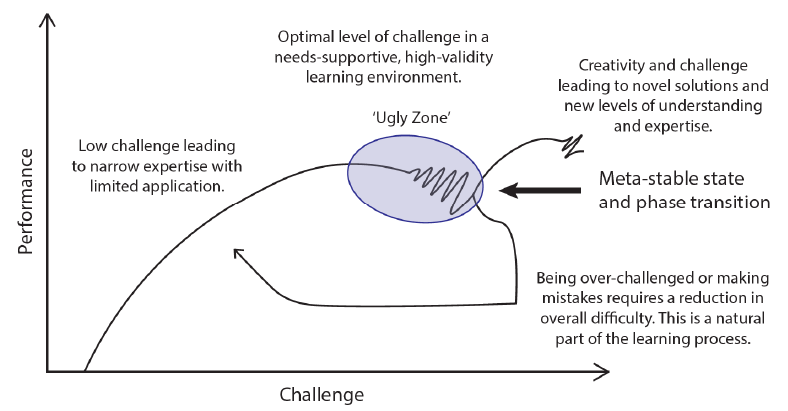
Figure 4. Dynamics challenge-performance curve, adapted with permission from Davies, M.J. and Davies, R.S. [10]. The complex relationship between demands of a task and expected performance output are represented by a performance curve, where individual, task, and environmental de- mands are combined to represent overall challenge. Limited overall demands result in a performer remaining under-challenged, lacking the opportunity to expand their expertise. With increasing dif- ficulty, performance trends upwards towards the ugly-zone; a point of optimal challenge, where the opportunity to develop expertise is maximised, as new implicit and explicit affordances become available through interaction with dynamic constraints in real-time. Within the ugly-zone, perfor- mance becomes unstable, converging on a bifurcation point and presenting the risk of errors being made, or a drop in performance arising from the learner becoming overwhelmed or over-chal- lenged. The curve shows that to get back to the optimal performance, overall challenge needs to be reduced significantly to allow reflection and learning (hysteresis). Despite this risk, it is important that the ugly-zone be perceived as a place of opportunity for learning and development of expertise within a well-managed, needs-supportive learning and performance